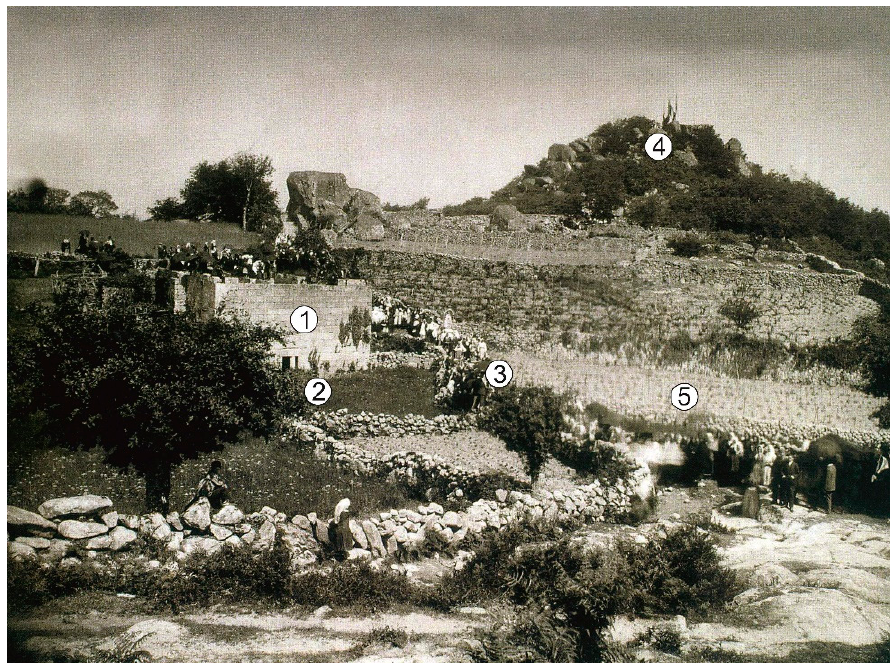
Figure 5. Anonymous photograph of the Basilica and its surroundings during the celebration of Santa Mariña day (18th of July) in the 1930s. The area was under agricultural use, although some of the plots, including the one in which the Basilica is located are grasslands. The numbers show the different landmarks mentioned in the text: (1) the Basilica, unfinished since 13th–14th centuries, when the currently visible structure was built, and under which is the Forno da Santa ; (2) plot in which the SM3 core was collected; (3). Path that communicates the parish church with the Outeiro dos Pendóns (4) which is the highest topographical elevation of the nearby Iron Age hillfort Castro de Armeá ; and (5) non ‐ terraced farmed agricultural plots.